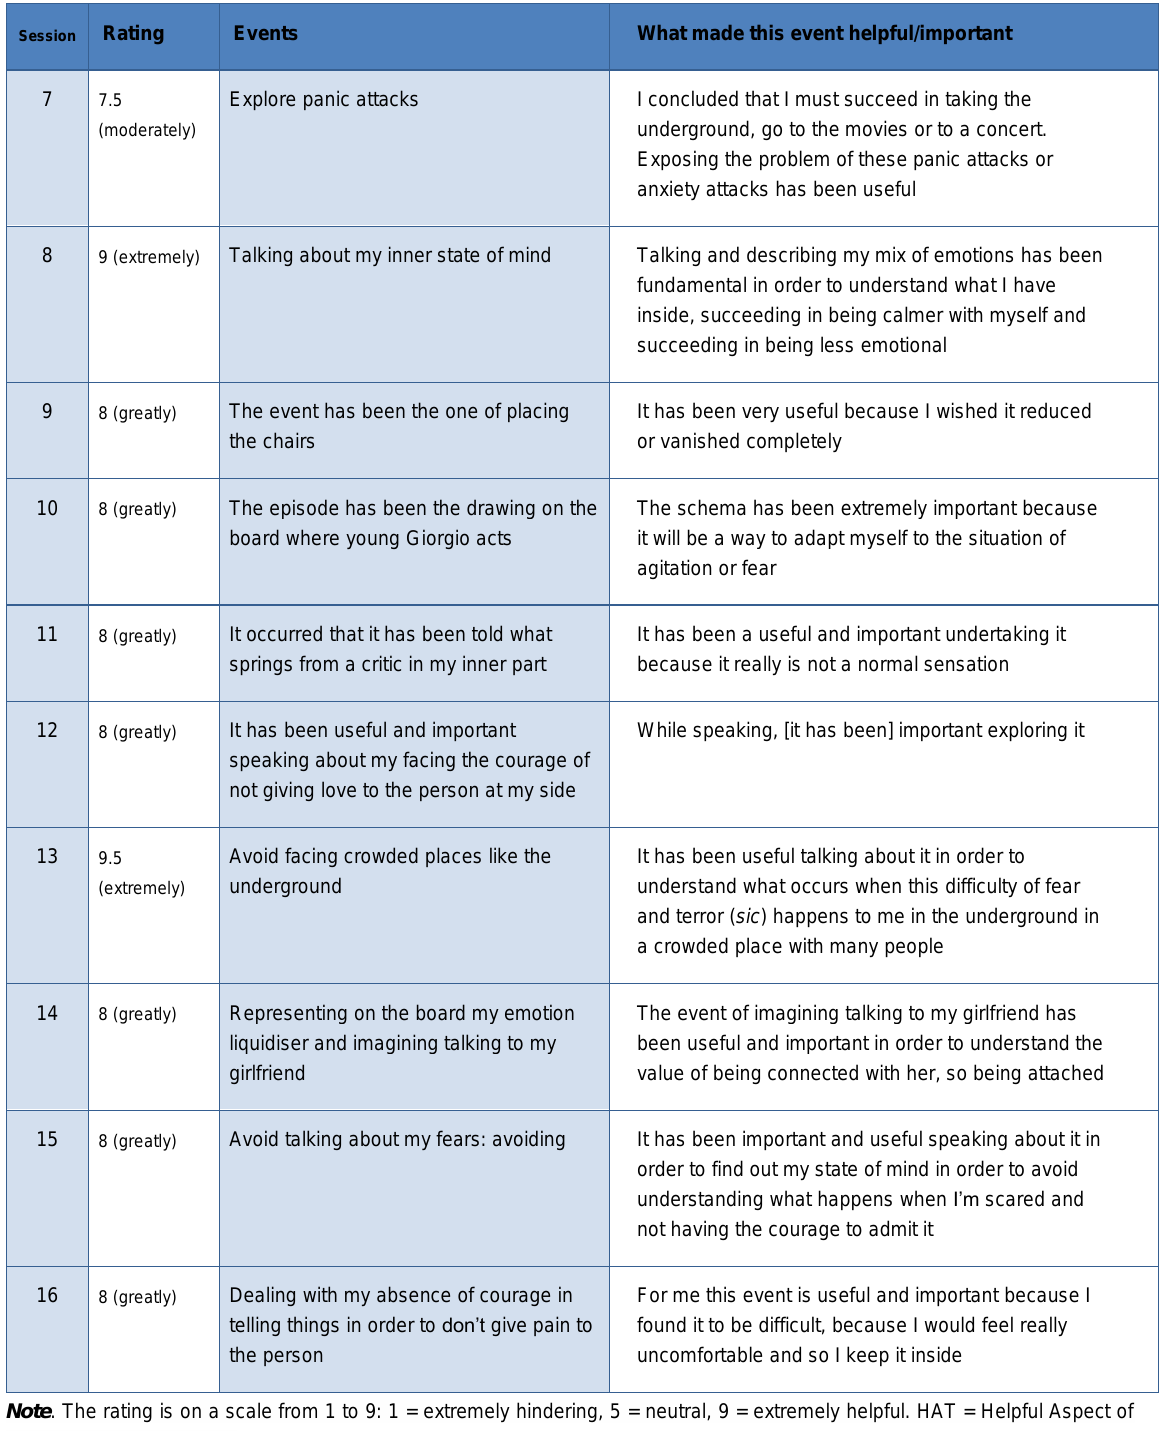
Table 3: Giorgio’s helpful aspect of therapy (HAT